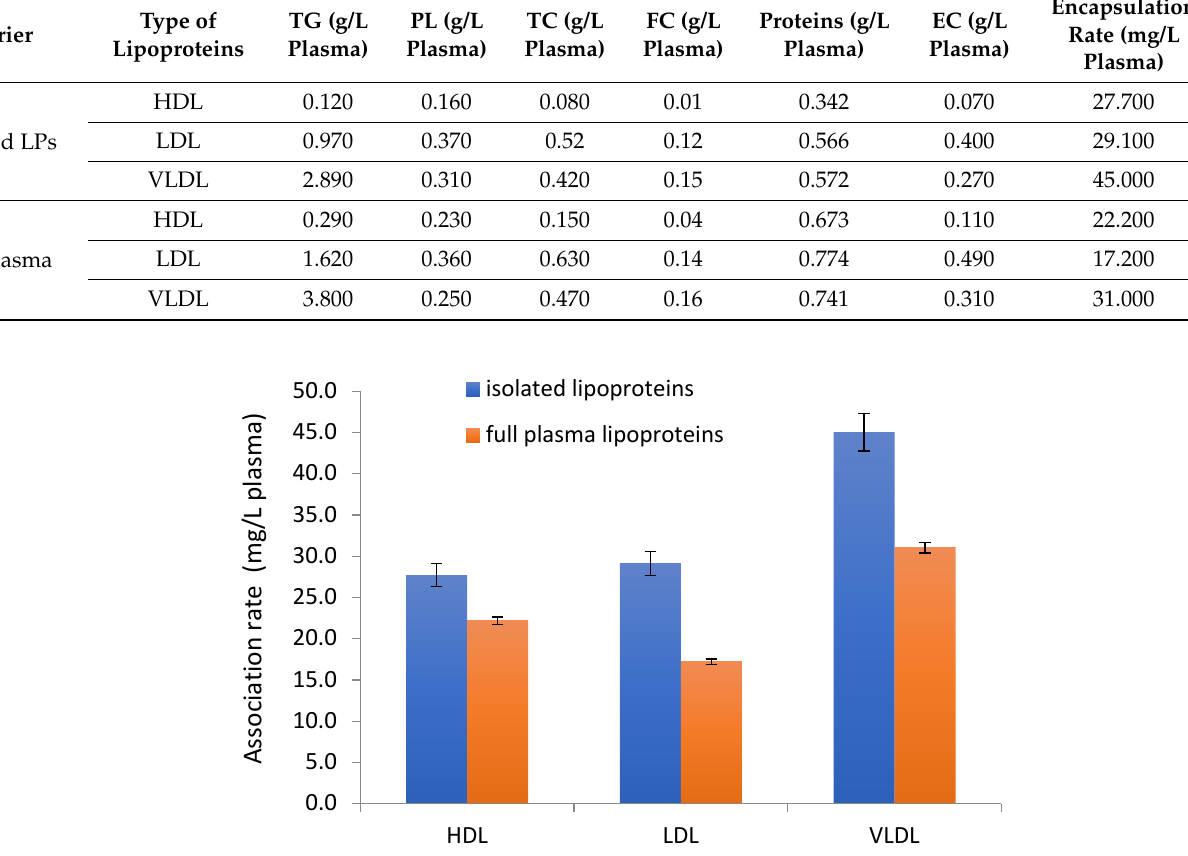
Figure 2. Difference in the association rate of cyclosporine with the different types of lipoproteins before and after separation from the plasma.